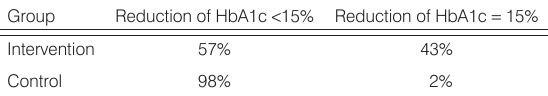
Table 6. The distribution of participants by level of reduction of HbA1c value and study groups.